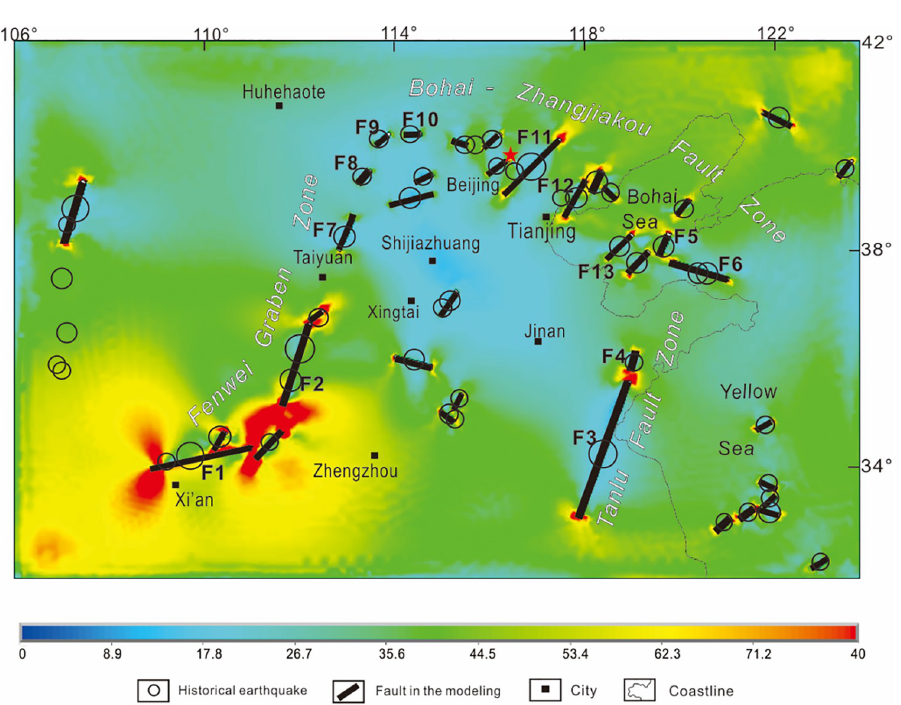
Fig 7. Maximum shear strain calculated by the model and historical earthquakes in the CNCB. Black lines denote the seismogenic faults. The highest strain value is located in the southern part of the Fen-wei Graben Zone. The lowest strain value is located in the northern part of the Fen-wei Graben Zone. Moderate strain values are located in the Bohai-Zhangjiakou Fault Zone and the Tan-lu Fault Zone.